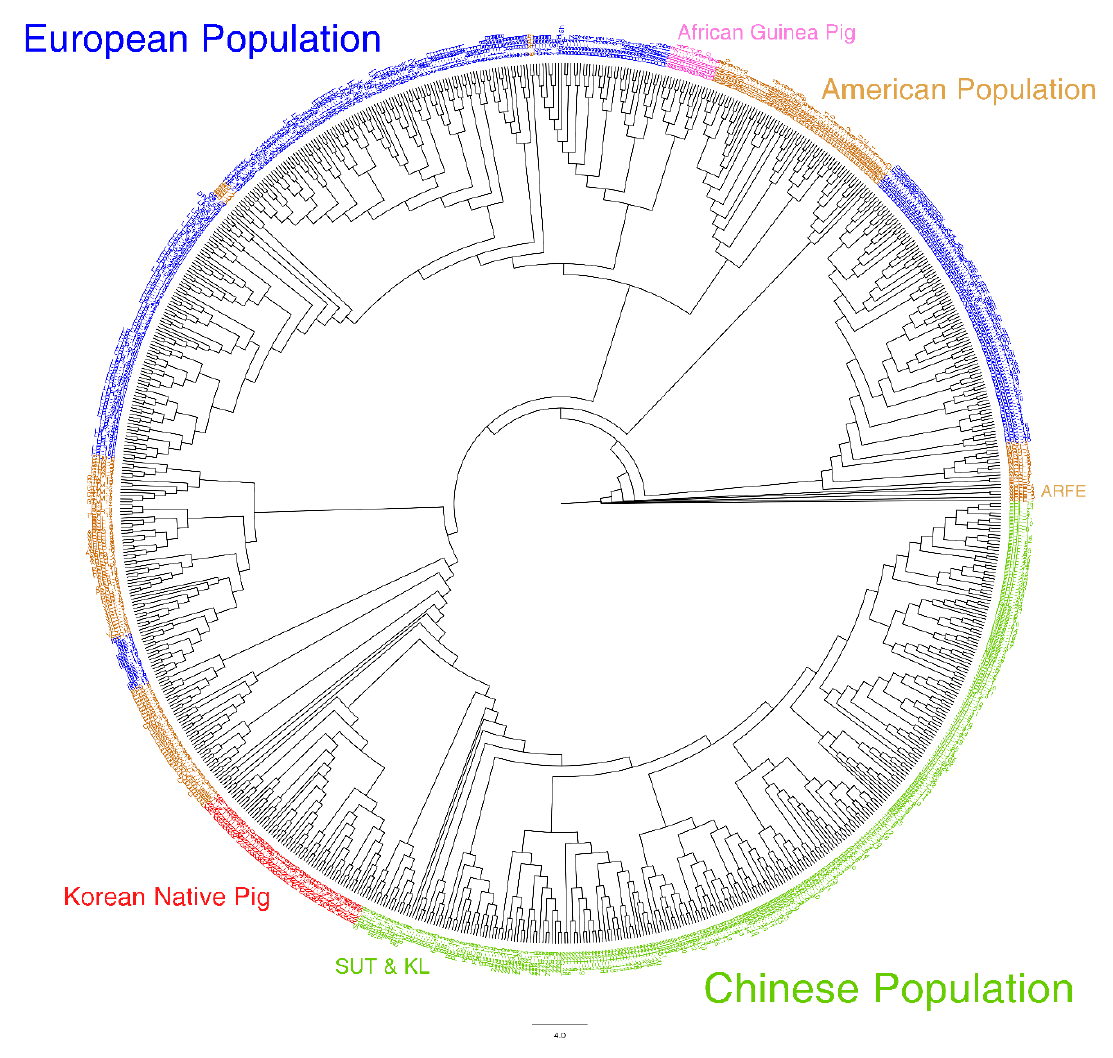
Figure 3. Maximum likelihood phylogenetic tree (created using SNPhlyo) of the pig populations in this study. (Argentina Feral (ARFE), Argentina Formosa Semi Feral (ARFO), Argentina Misiones Creole (ARMS), Bamaxiang (BMX), Bolivia Creole (BOL), Berkshire (BS), Bisaro (BSR), Cuba Eastern Creole (CBE), Cuba Western Creole (CBW), Mexico Cuino (CMX), Colombia Creole (COL), Costa Rica Creole (CRC), Colombia Zungo (CZG), Duroc (DRC), Dongshan (DS), Ecuador Creole (ECD), Erhualian (EHL), Guatemala Creole (GTM), Guinea Hog (GUN), Ganxi (GX), Hampshire (HAMP), Mexico Hairless (HMX), Iberian (IBE), Jinhua (JH), Jiangquhai (JQH), Kele (KL), Korean Native (KNP), Landrace (LR), Large White (LW), Meishan (MES), Brazil Monteiro (MON), Brazil Moura (MOU), Min (MZ), Ossabaw (OSS), Peru Creole (PER), Brazil Piau (PIU), Rongchang (RC), Sutai (SUT), Shaziling (SZL), Tongcheng (TC), White Duroc (WD), Xiang Pig (XIANG), Yucatan (YCT), Yorkshire (YS), Tibetan Gansu (ZZG), Tibetan Tibet (ZZT).)